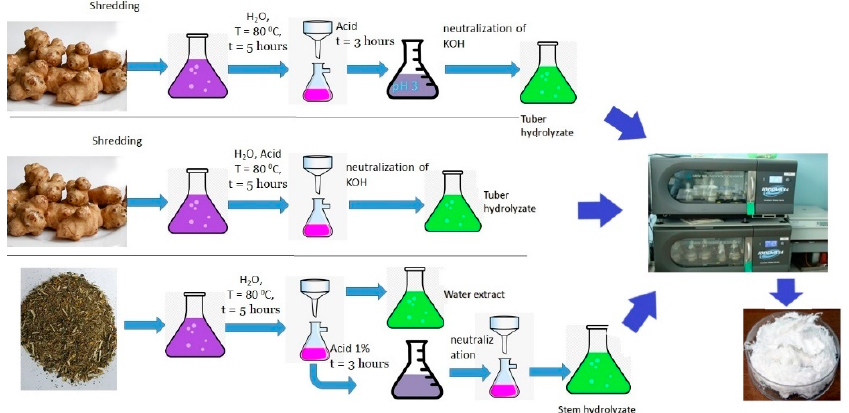
Figure 1. The scheme of hydrolysate production from JA tubers and vegetative part used as substrate for PHA synthesis by the bacteria C. necator B-10646, R. eutropha B5786 and 8562.